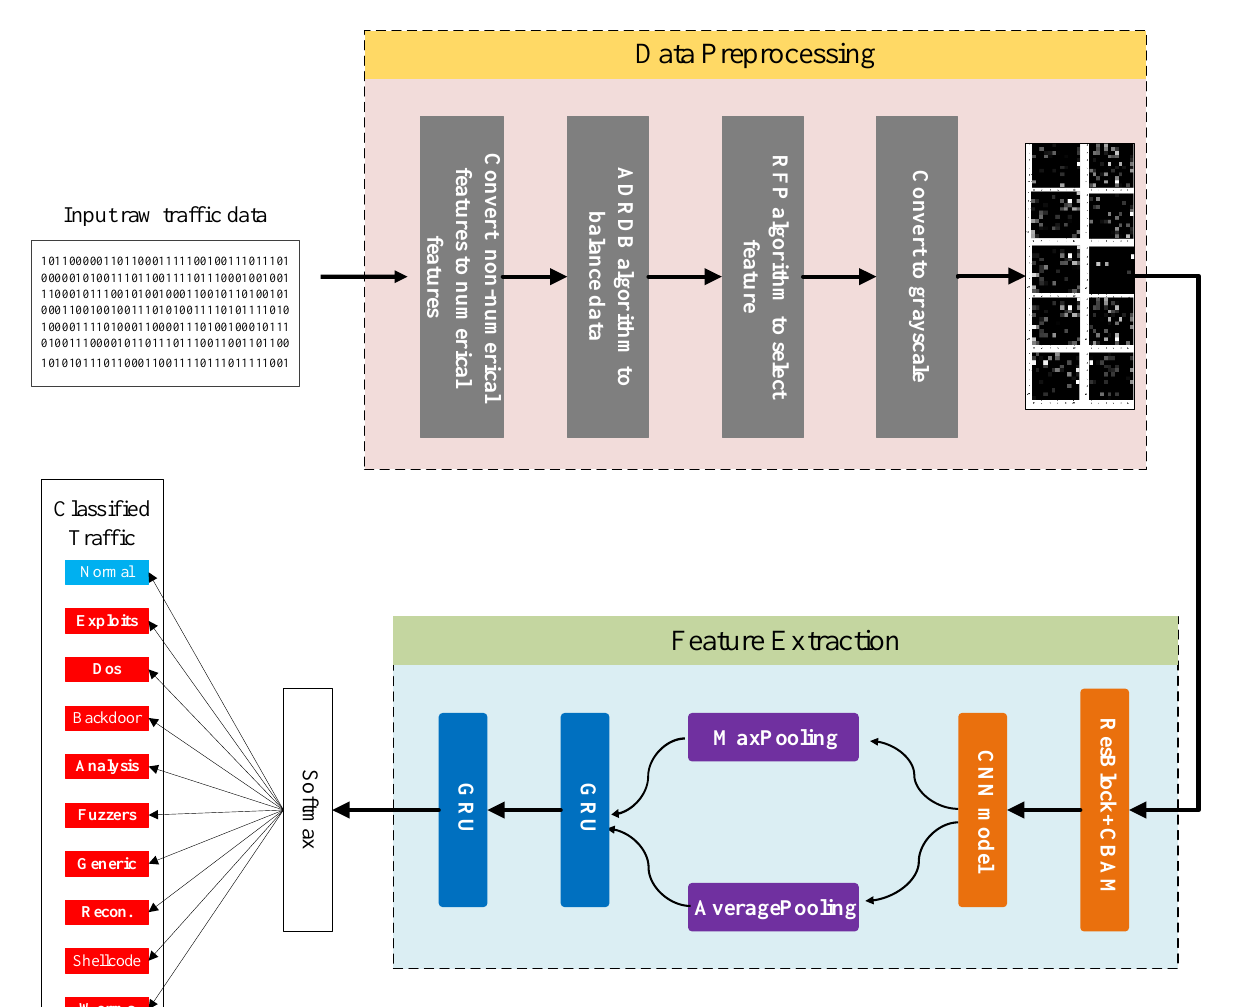
Figure 1. Network Intrusion Detection Model Based on CNN and GRU.